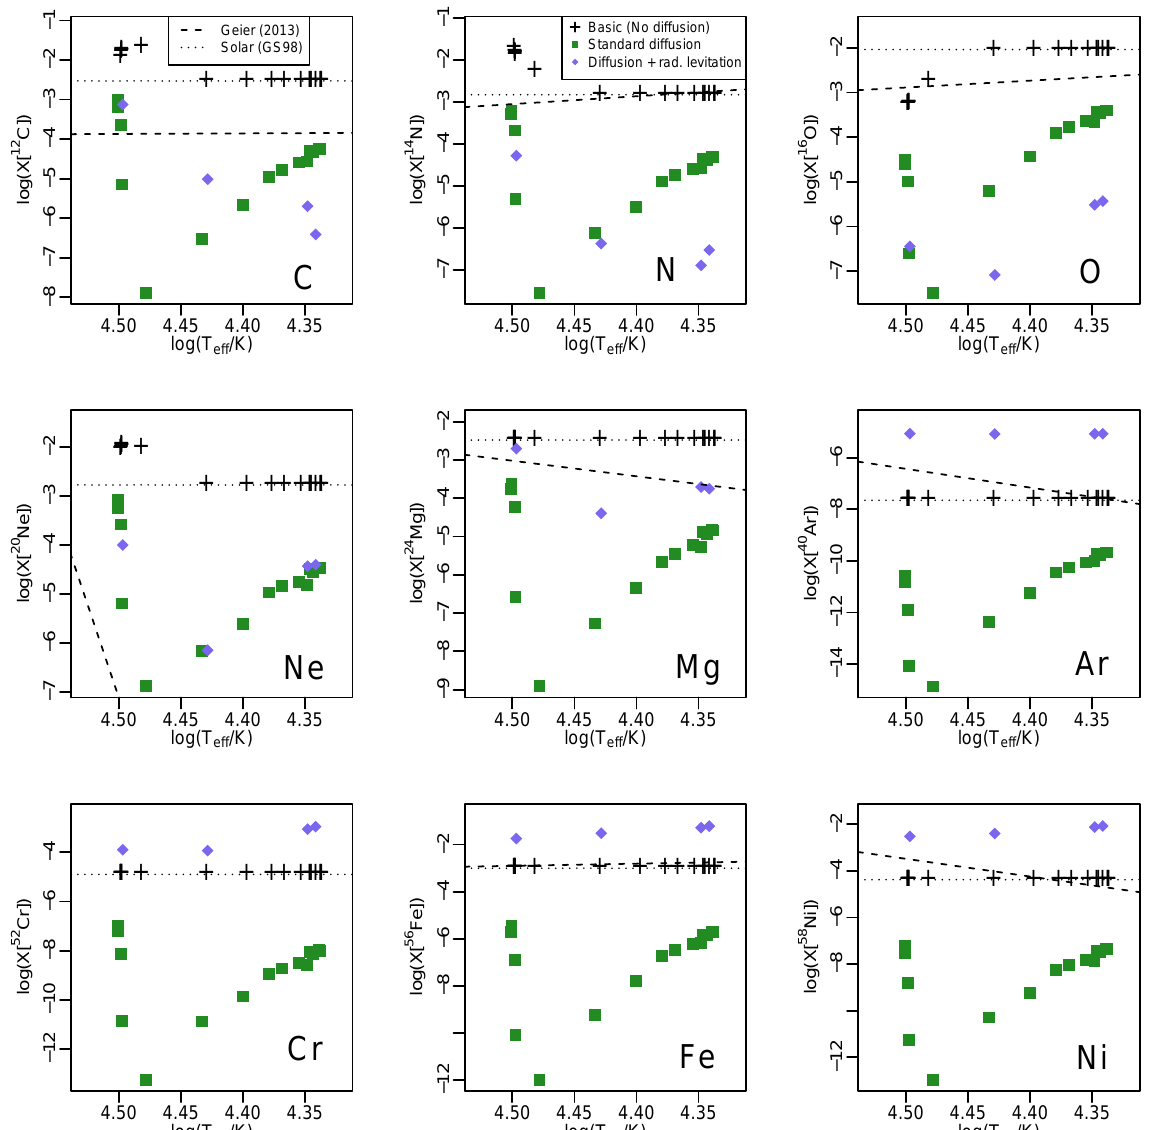
Figure 2. Envelope mass fractions as a function of effective temperature for zero-age horizontal branch models. The symbols and lines have the same meaning as in Figure